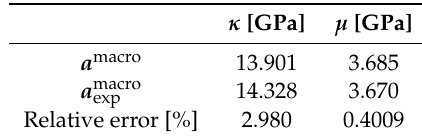
Table 1. Comparison between the identified optimal value a macro and the reference experimental value a macro exp